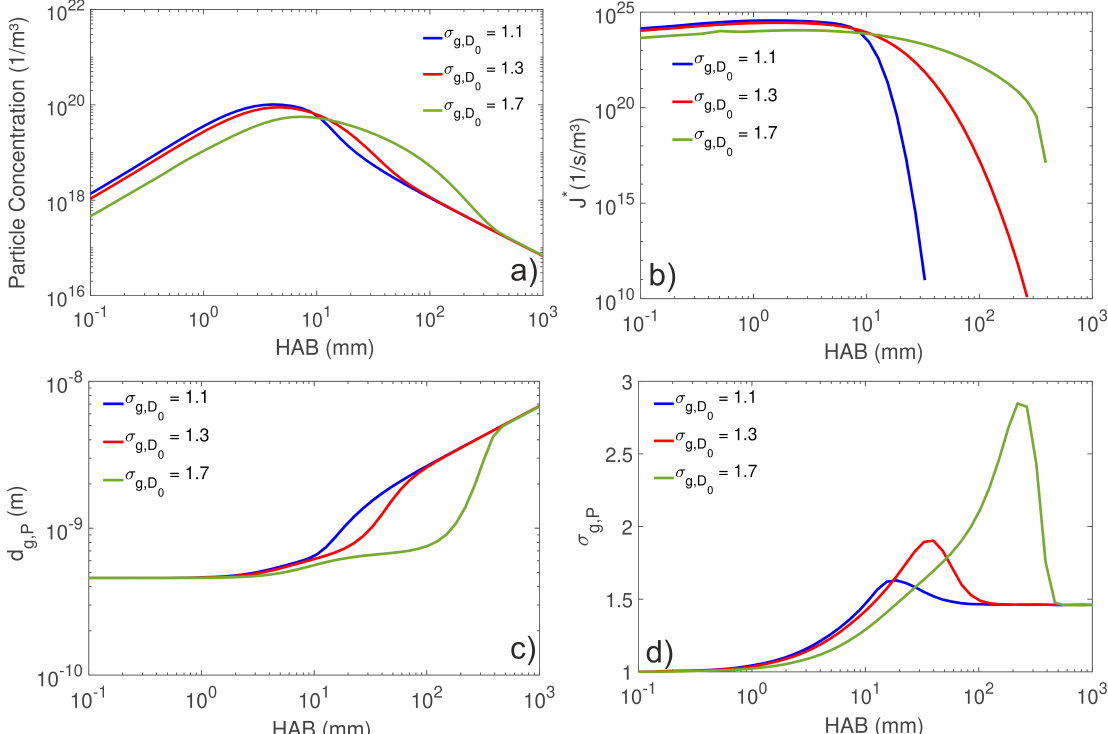
Figure 11. ( a ) Particle concentration over HAB; ( b ) number of total nucleated Fe 2 O 3 monomers over HAB; ( c ) evolution of d g,P over HAB; ( d ) σ g,P of ≈ 1.46 is reached for all simulations at HAB = 1000 0